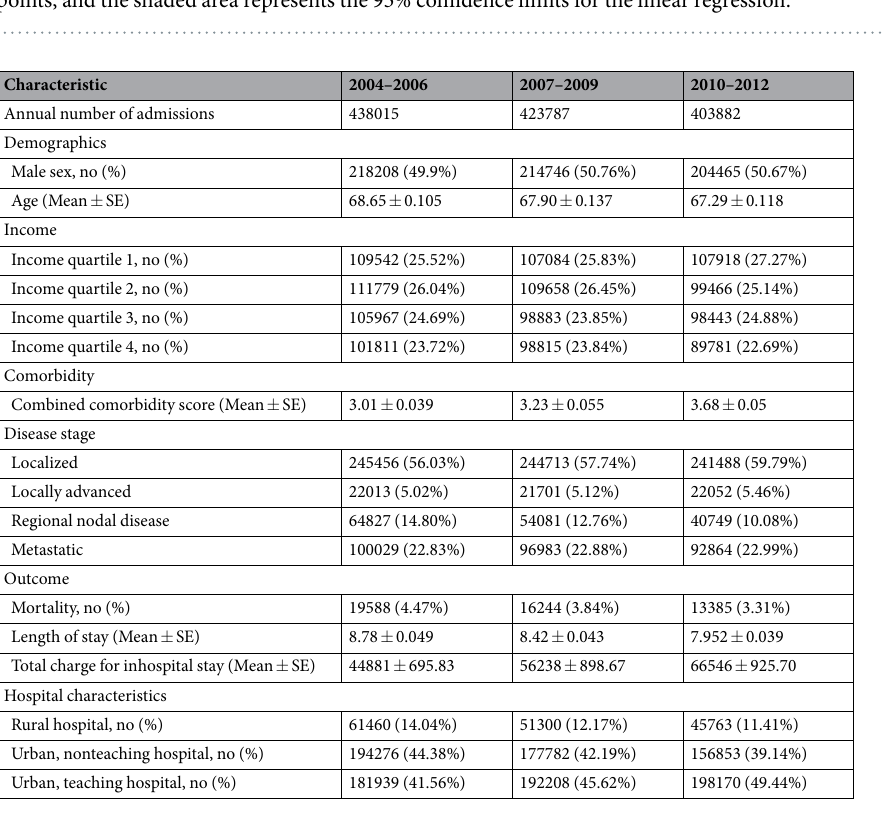
Figure 1. The trend of colon cancer admission ( A ) and in-hospital mortality ( B ) between 2004 and 2012. Circle represents the number of admissions/deaths in a given year, the straight line is a linear regression on all the data points, and the shaded area represents the 95% confidence limits for the linear regression.